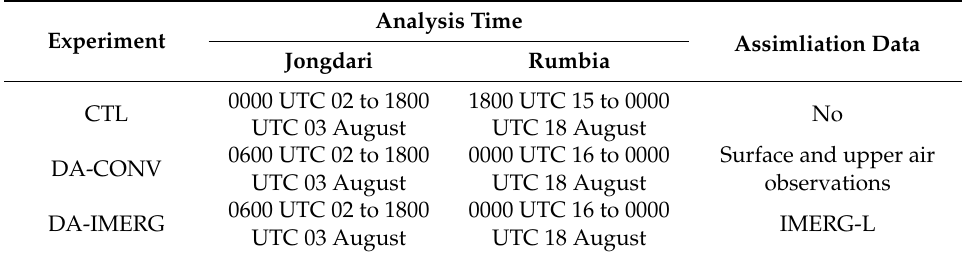
Table 2. Brief description of experiment